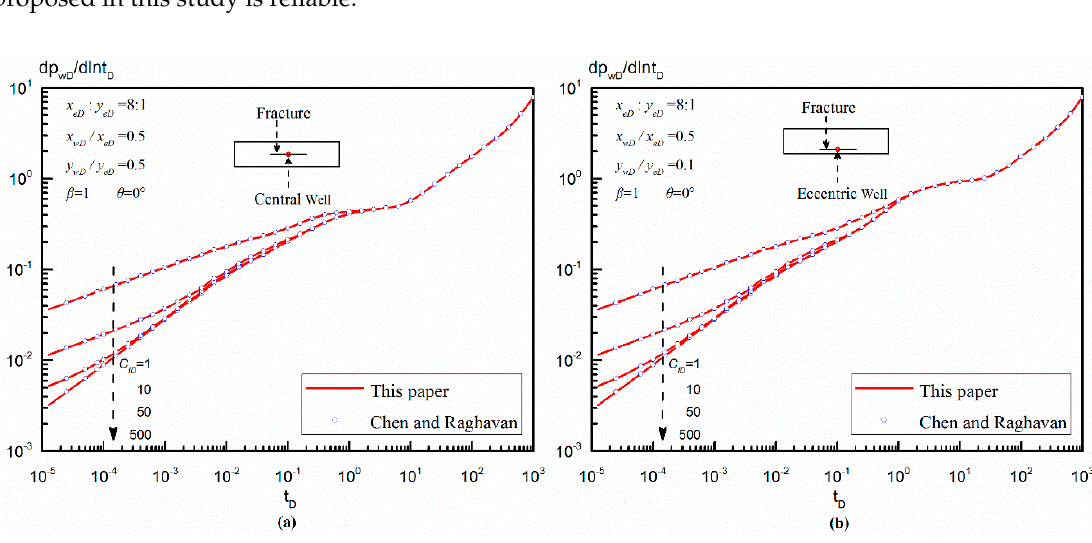
Figure 4. Validation of a finite-conductivity fracture with an azimuth angle in an anisotropic reservoir. 5. Pseudo-Steady-State Flow Parameters Pseudo-steady-state constant and pseudo-skin factor are two key parameters in the PSS flow period, which can help us to understand this period’s characteristics and also analyze this period’s productivity. In this section, pseudo-steady-state constant and pseudo-skin factor corresponding to our model were obtained with the asymptotic analysis method. 5.1. Pseudo-Steady-State Constant Pratikno et al. (2003) proposed a pseudo-steady-state formula when developing an analytical solution for a single finite-conductivity fracture in the isotropic circular reservoir [6]: (